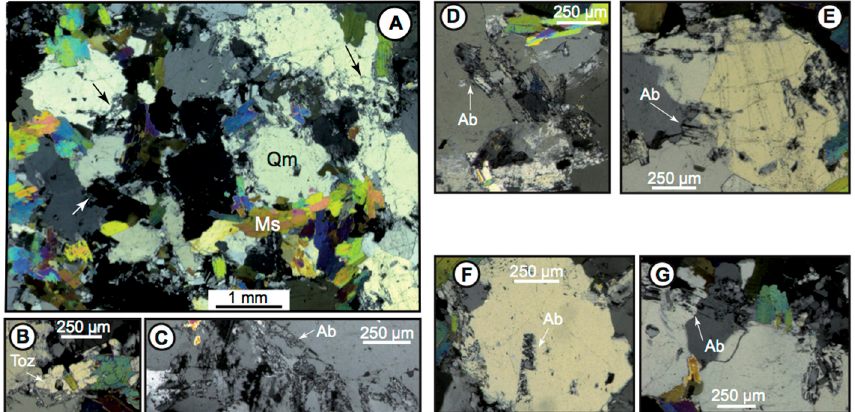
Figure 5. Photomicrographs and SEM-BSE images of albite habit in the greisenised G4 granite (L2 level) (cross-polarized light, sample PNQ-19a). ( A ) Overall view of the greisen. The rock mainly consists of quartz and muscovite (Ms), with albite ghosts overprinted by quartz (arrows). Qm relic snowball quartz. ( B ) Skeletal topaz included in quartz. ( C – G ) Lace-shaped ghosts of albite crystals invaded by quartz. Ab: albite, Toz: topaz.